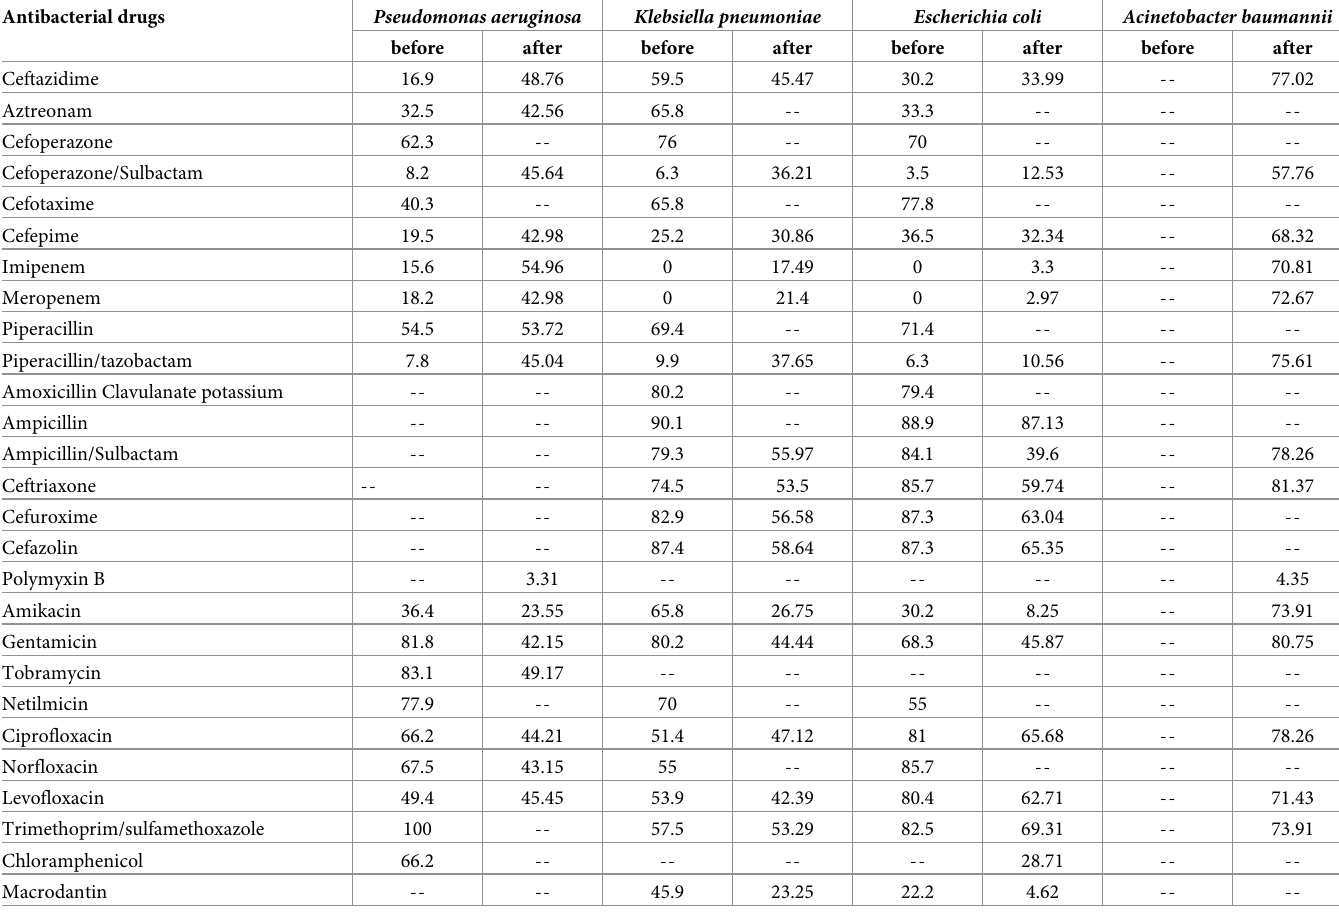
Table 3. The change in the resistance rate (%) of the main Gram-negative bacilli to common antibacterial drugs before and after 13 years. Antibacterial